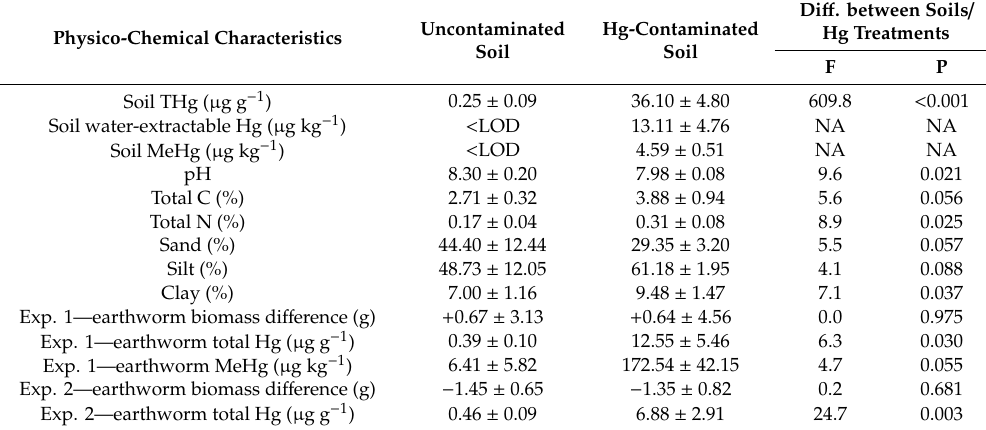
Physico-chemical characteristics of the uncontaminated (experiment 2 only) and Hg-contaminated (experiments 1 and 2) soils and the earthworms used for the incubation experiments. The di ff erence between the soils or Hg treatment was tested with an ANOVA. Exp. 1 = Experiment